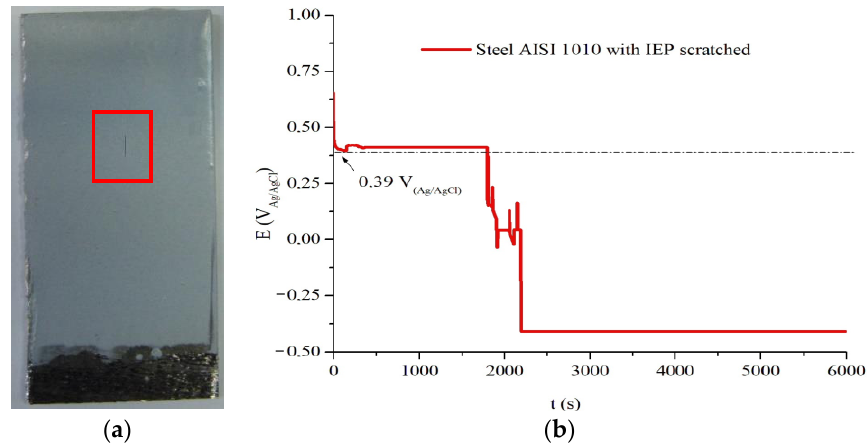
Figure 9. ( a ) image of the IEP coated AISI 1010 steel plate containing an failure intentional in coating; ( b ) OCP vs. time of AISI 1010 steel with scratched IP of CER coatings, exposed to aqueous solution of 2 mol L −1 H 2 SO 4 . 2 mol L − 1 H 2 SO 4